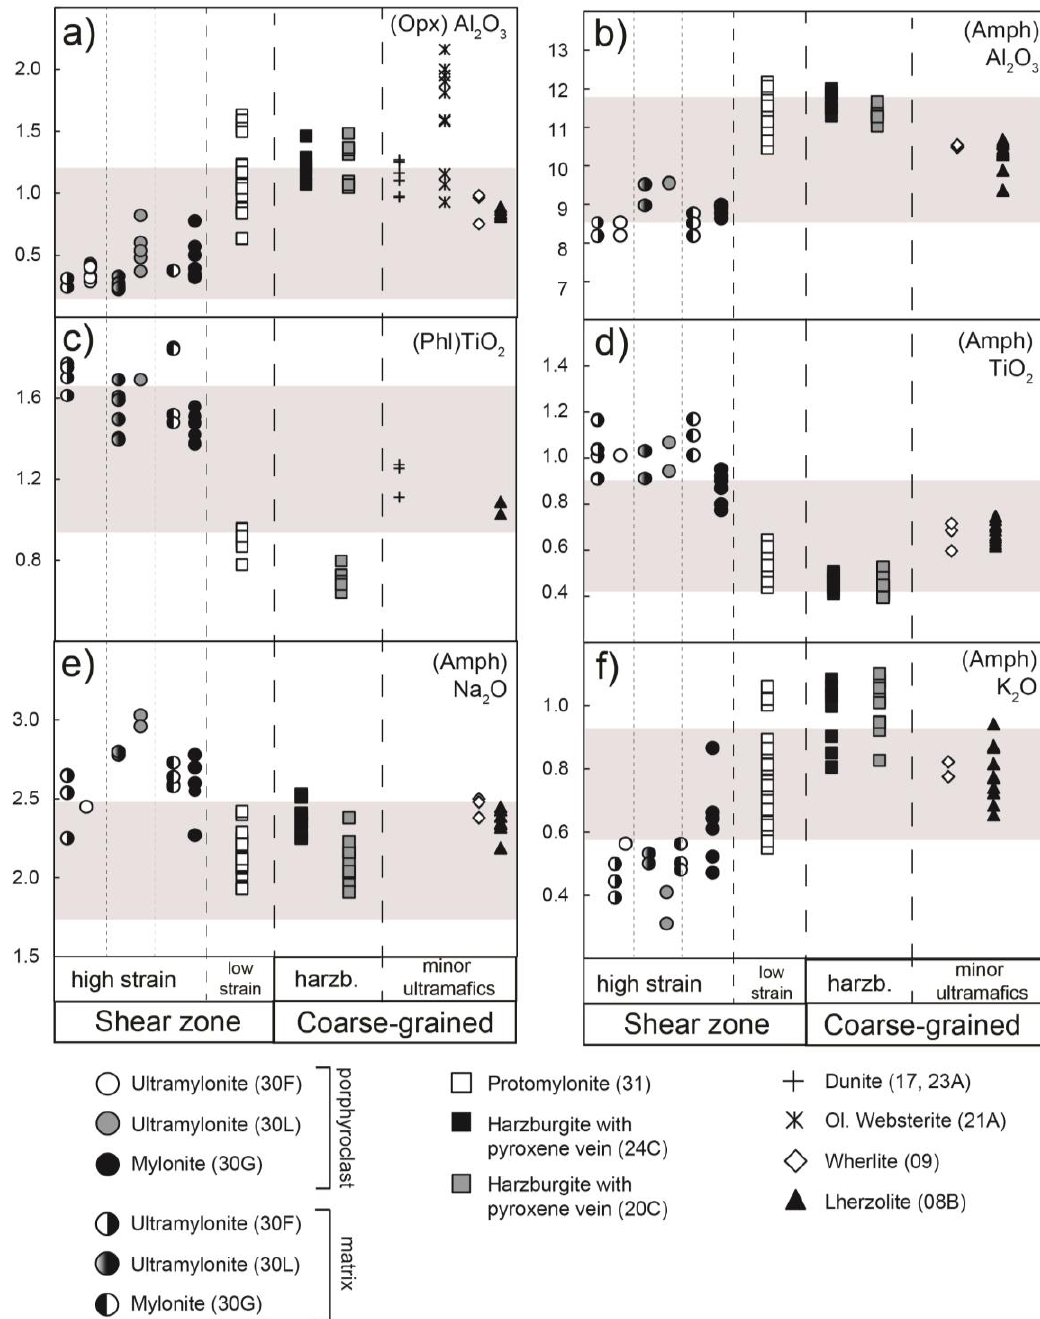
Figure 6. Major element content (wt.%) in mineral phases of Finero Ph-Pd samples: ( a ), ( b ) Al 2 O 3 in orthopyroxene and amphibole; ( c ), ( d ) TiO 2 in phlogopite and amphibole; ( e ) Na 2 O and K 2 O ( f ) in amphibole. The grey band refers to the range from literature data [1,15,17].